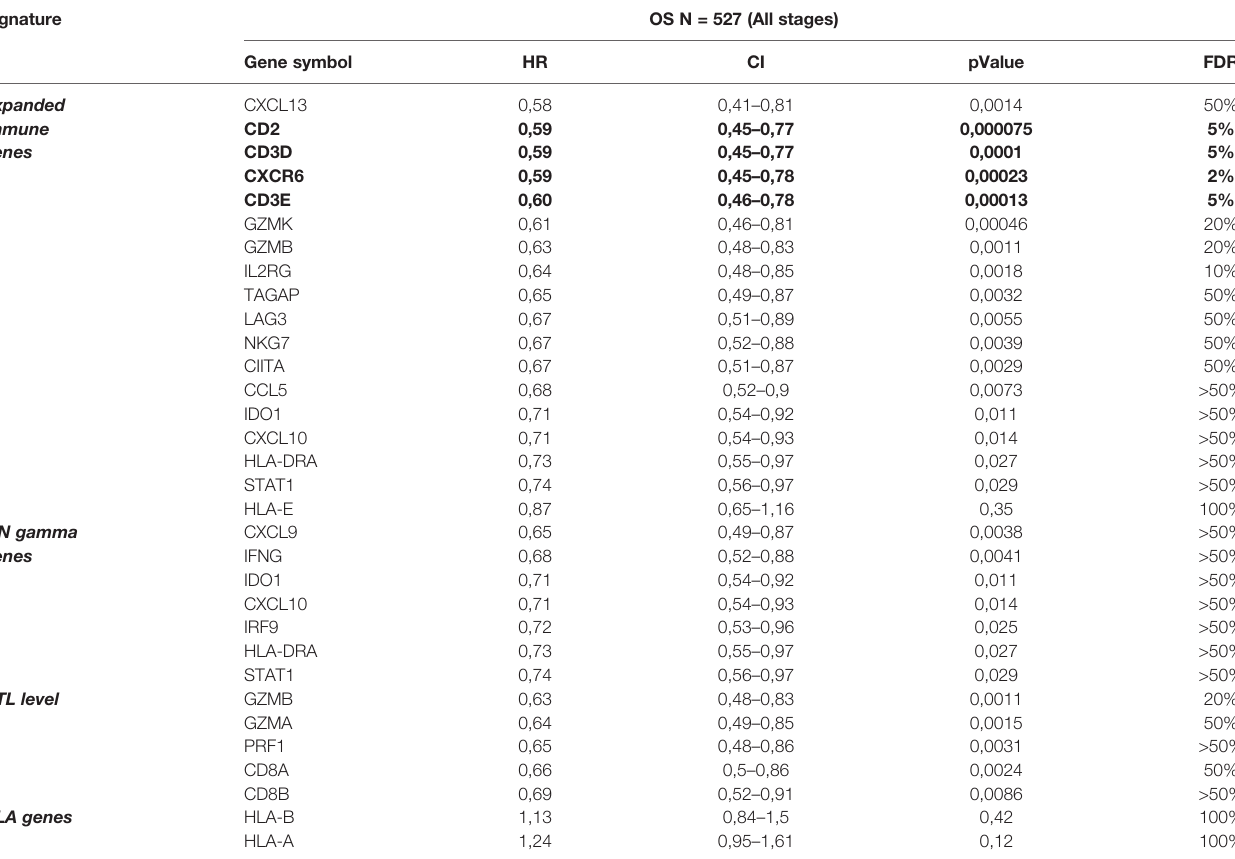
TABLE 2 | Clinical outcome of individual immune genes from the four immune gene signatures in terms of overall survival (OS) of HNSCC